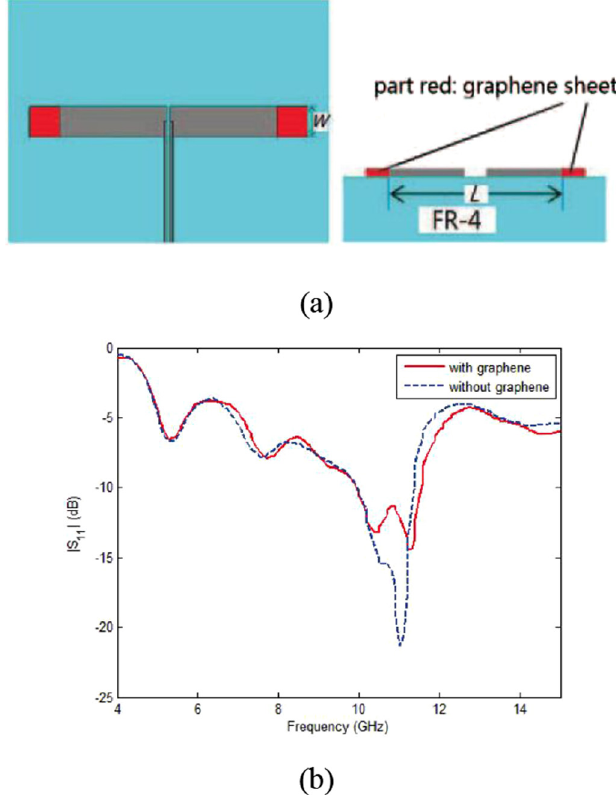
Fig. 9. (a) The con fi guration of the dipole antenna. Red part is the graphene sheets. (b) Measured | S 11 | of the dipole antenna with graphene and without